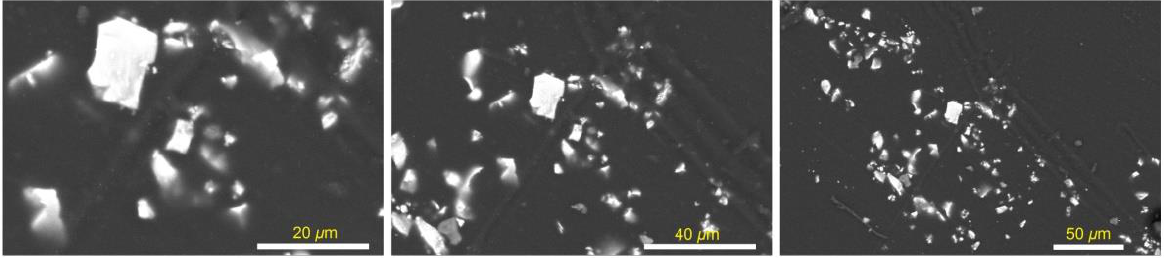
Figure 3. XRD patterns of SAPN ( top ) and its standard spectrum ( bottom ).